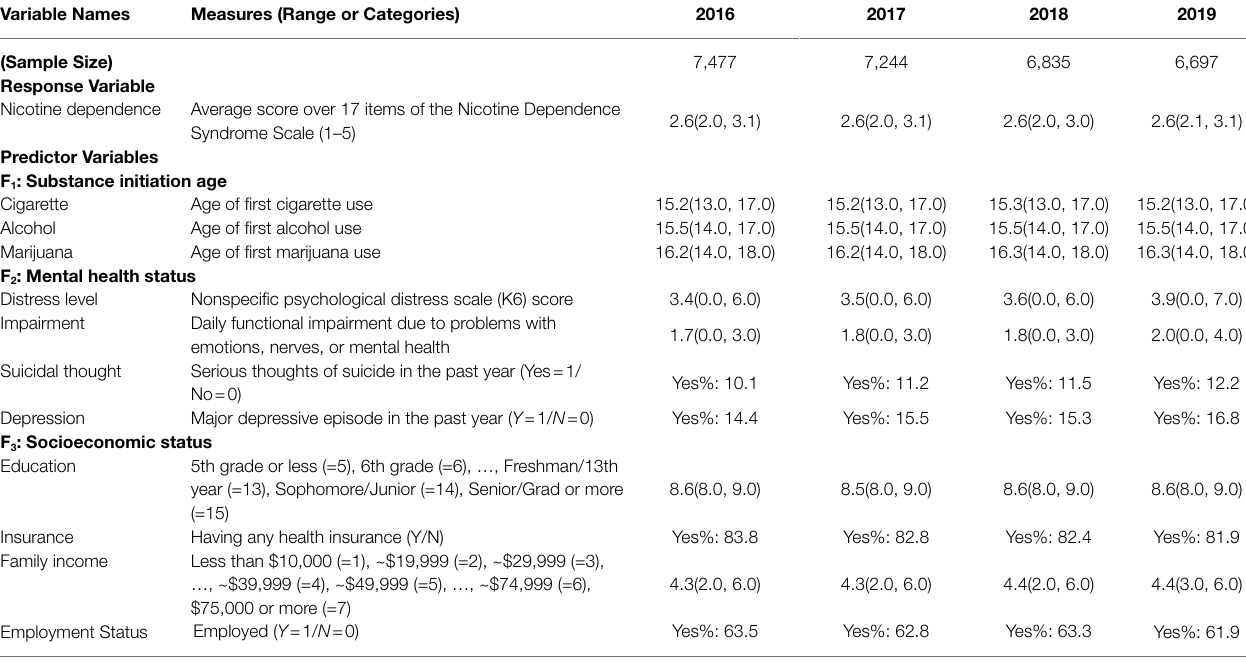
TABLE 1 | Description of variables and summary statistics for the NSDUH data (2016 ~ 2019).